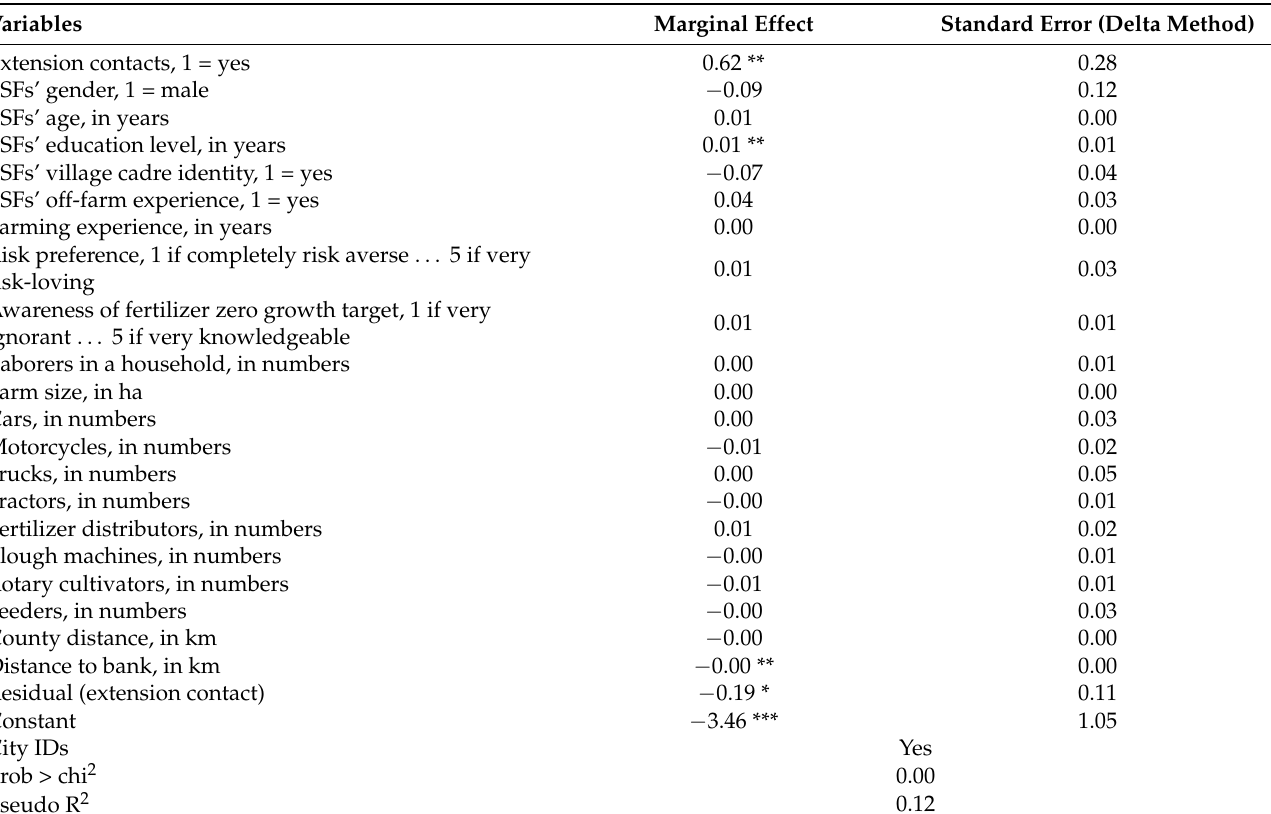
Table 2. Regression results using a two-step control function